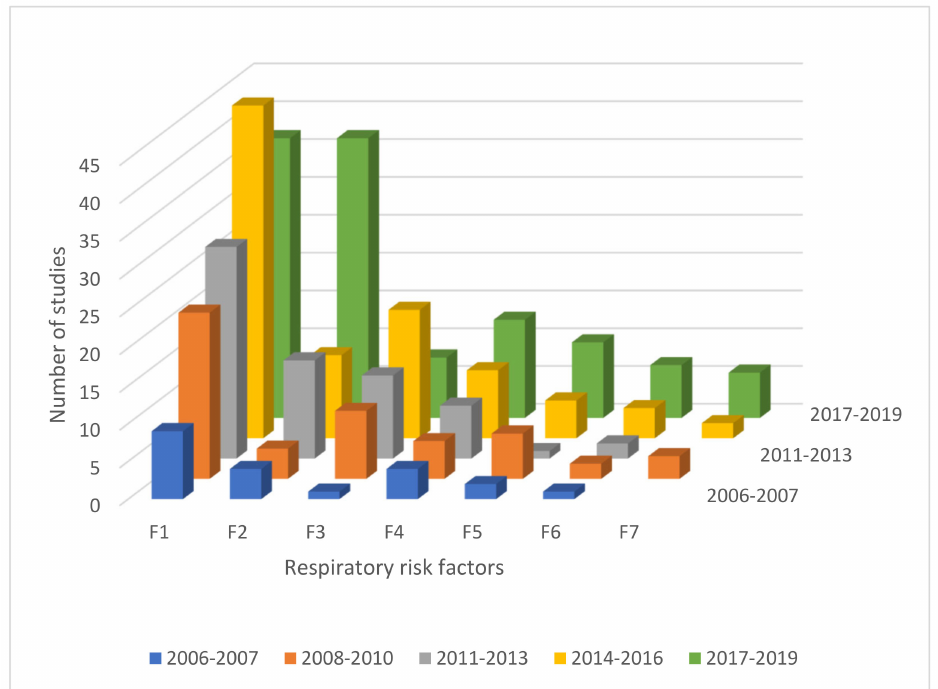
Figure 6. Evolution of consideration of respiratory risk factors in publications over time. Note: F1—Living close to city areas, main roads, highways or industrial areas, F2—Exposure to solid fuel, F3—Meteorological factors, F4—Exposure to ETS, F5—Moisture or mould damage, F6—Exposure to radon, F7—Exposure to indoor asbestos